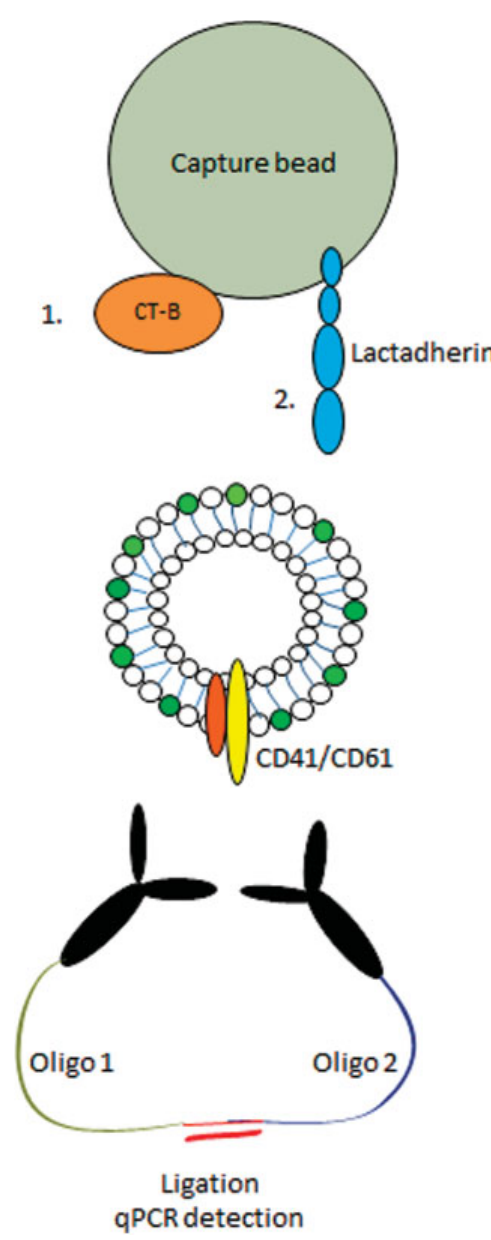
Fig. 1 SP-PLA method for detecting EVs. CT-B or lactadherin is bound to capturebeads.Capturebeadswithaf fi nityreagentarethenincubatedwith plasmadilutedinPLAbuffer tocaptureextracellular vesicles.Aftercapture, the beads are washed and incubated with antibodies detecting CD41 or CD61 conjugated to two different oligonucleotides, PLA probes 1 or 2, to detect the CD41/CD61 integrin which is present on the platelet surface